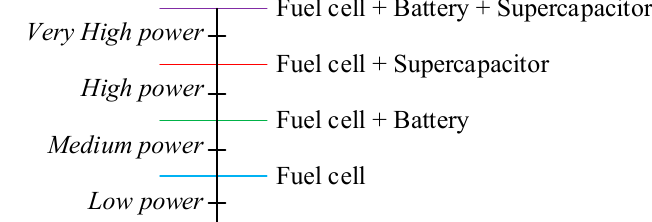
Figure 7. The level of the power demand.